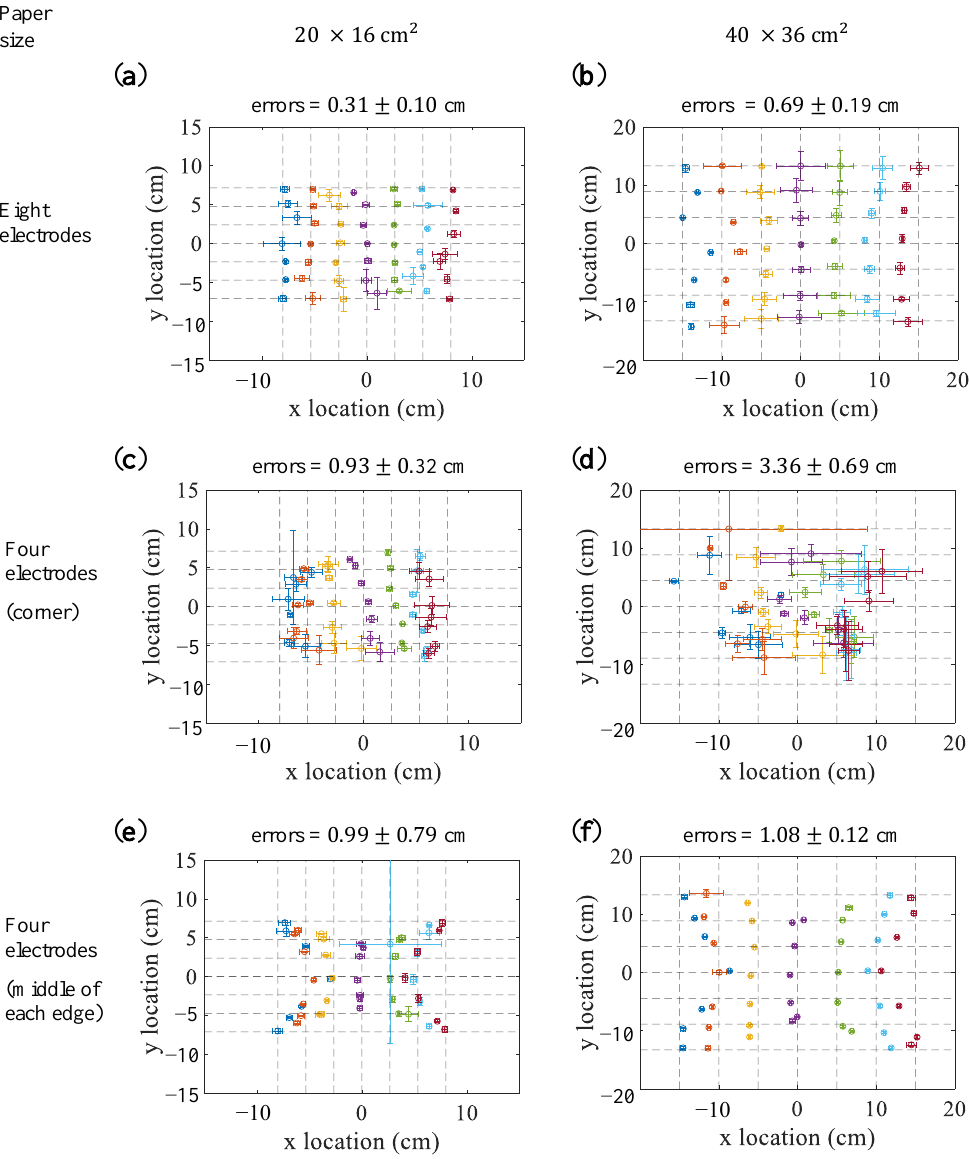
Figure 6. Results of the voltage ratio method obtained using four or eight electrodes. ( a , c , e ) show the results for the 20 × 16 cm 2 paper. ( b , d , f ) show the results for the 40 × 36 cm 2 paper. ( a , b ) show the results obtained using eight electrodes. ( c , d ) show the results obtained using four electrodes placed in the corners of the paper. ( e , f ) show the results obtained using four electrodes placed in the middle of the edges of the paper. The points denote the mean estimated locations for the intersection points, and the error bars denote the standard